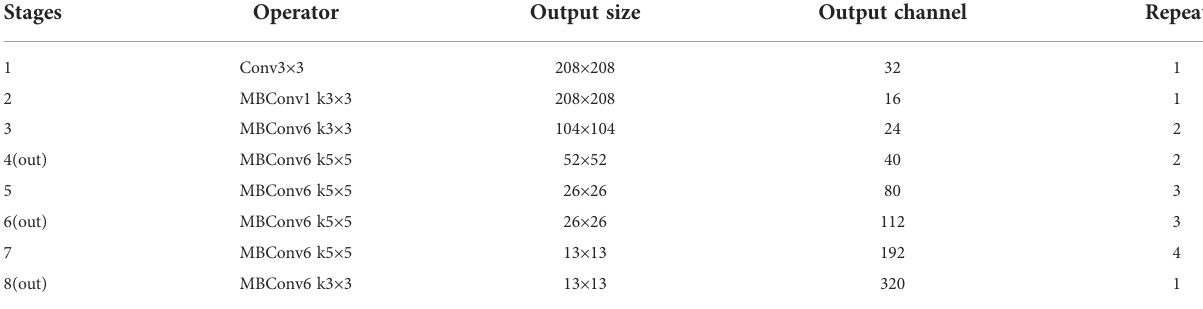
TABLE 1 The structure of Ef fi cientNet-b0